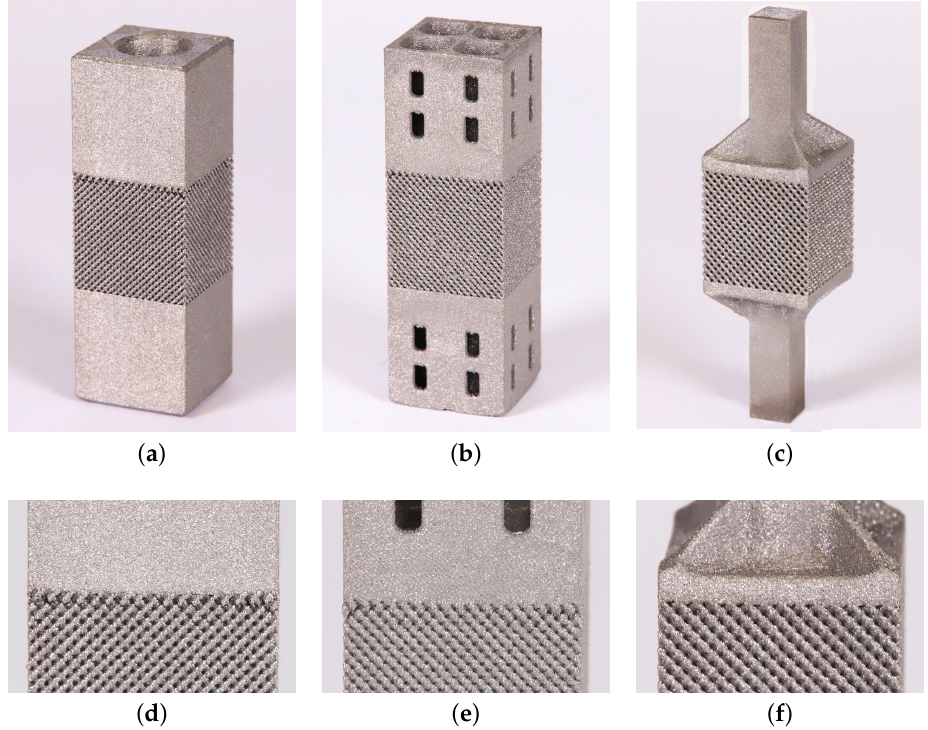
Figure 5. Trabecular specimens made for tension tests: ( a ) variant 1 (TT-V1), ( b ) variant 2 (TT-V2), ( c ) variant 3 (TT-V3), ( d ) visible interface defects TT-V1, ( e ) visible interface defects TT-V2, ( f ) no visible interface defects